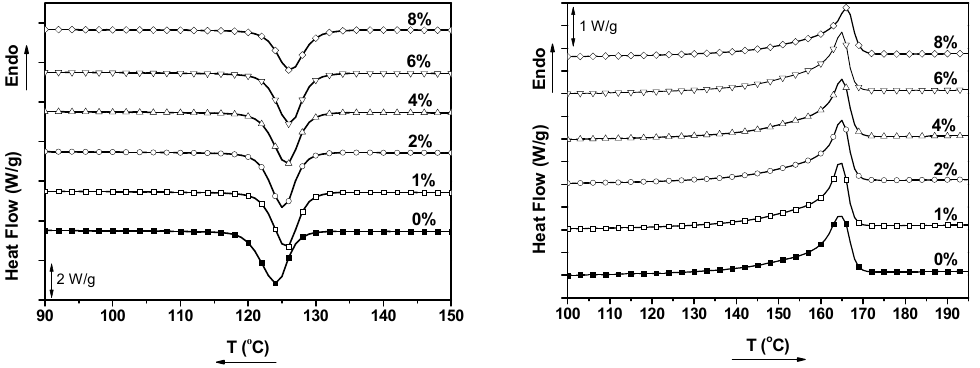
Figure 1. Differential Scanning Calorimetry (DSC) cooling and heating scans of neat PP and MWCNT/PP nanocomposites obtained at 10